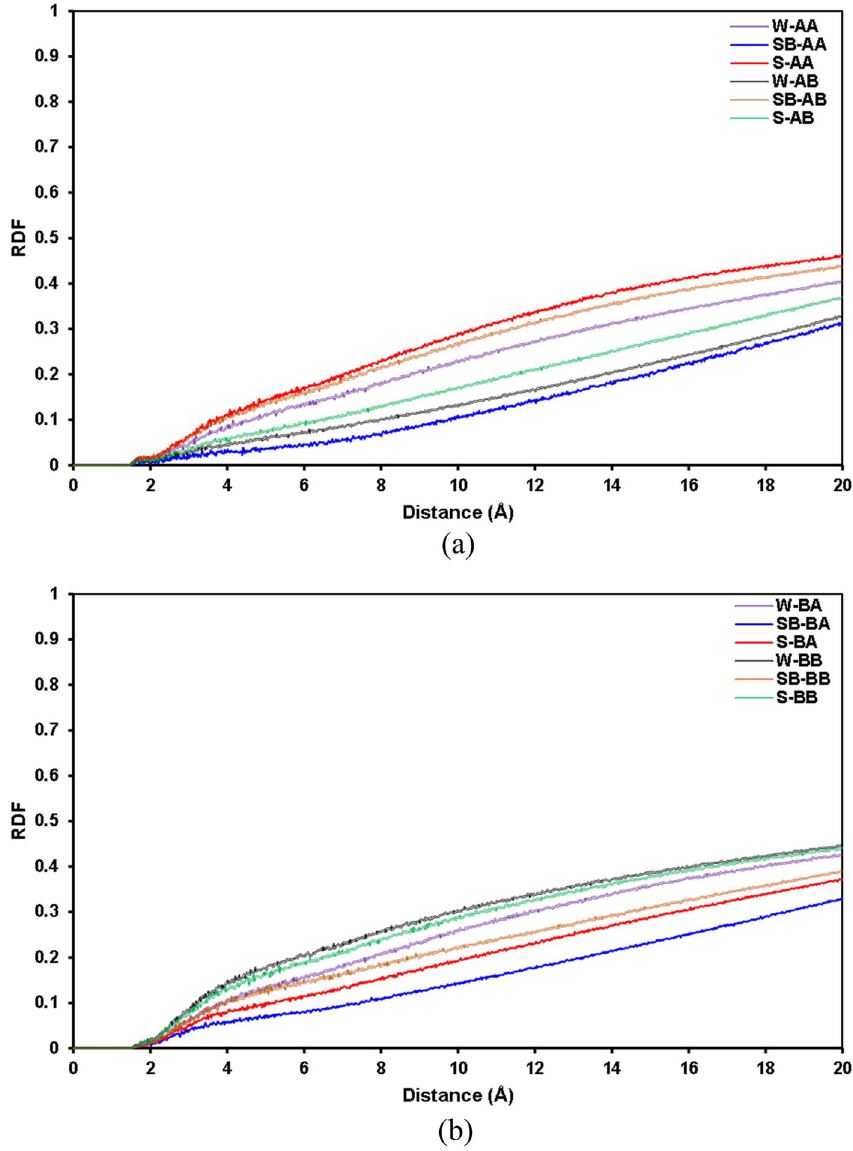
Figure 7. RDFs of the asphaltene–water molecule pairs containing ( a ) C 40 H 30 O 2 and ( b ) C 44 H 40 N 2